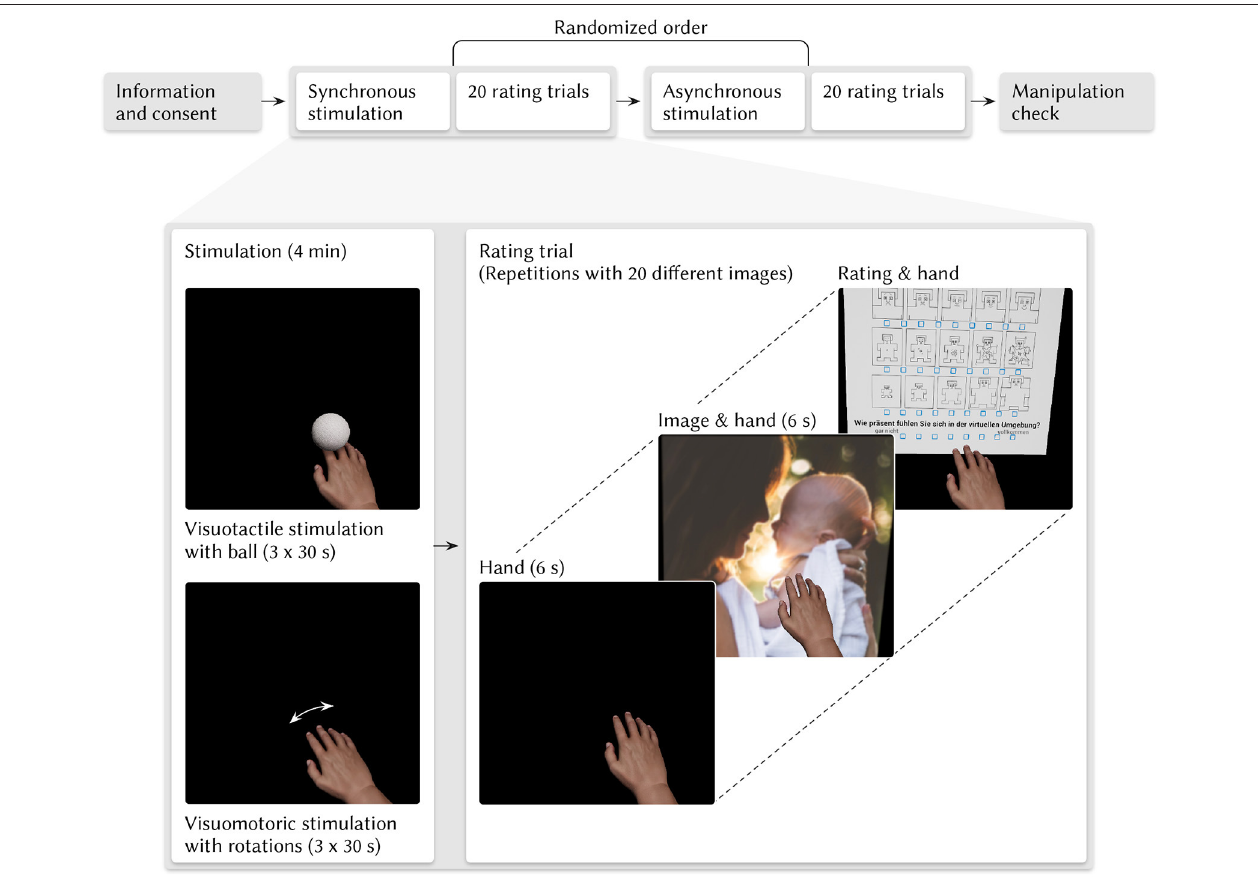
FIGURE 2 | Procedure and stimuli. Participants completed the synchronous and the asynchronous condition in a balanced randomized order. In each condition, participants received visuomotor and visuotactile stimulation for 4 min. We stroked the hands of participants with a ball and rotated their hands. In the synchronous condition, the hand and the virtual ball moved synchronously to the real hand and real ball. In the asynchronous condition, the virtual objects moved 5 s delayed. Afterward, participants completed 20 trials in each condition. In each trial, participants saw the virtual hand for 6 s, then an image with the virtual hand for 6 s. Afterward, they completed self-assessment manikin and presence ratings. After completing both conditions, participants answered a questionnaire to assess if the manipulation worked. Placeholder image stimulus by Julie Johnson on